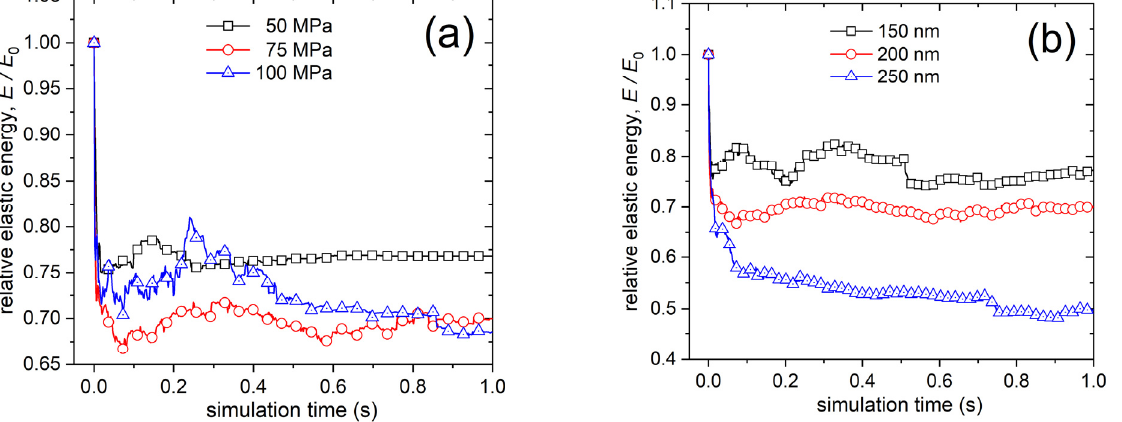
Figure 20. The relative (normalized to the initial value) elastic interaction energy as a function of simulation time calculated for different ultrasonic amplitudes ( a ) and different grain sizes ( b ). The grain size is 200 nm in ( a ) and ultrasonic amplitude is 75 MPa in ( b ) [114].